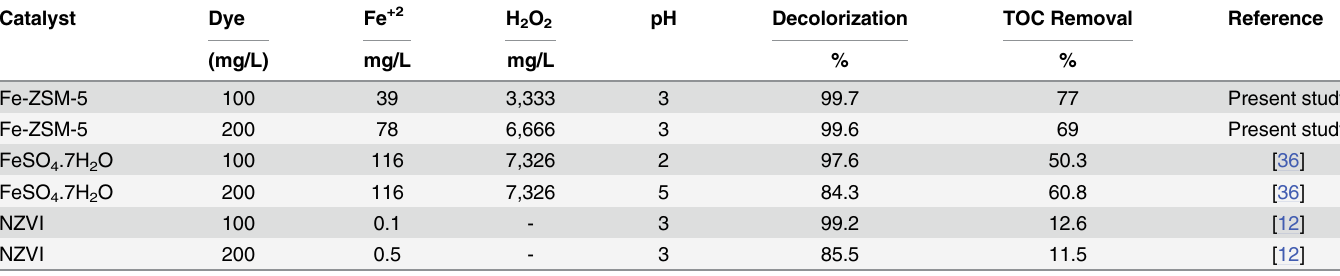
Table 13. Comparison of synthesized Fe-ZSM-5 with other catalysts used for the degradation of Acid Blue 113. Catalyst